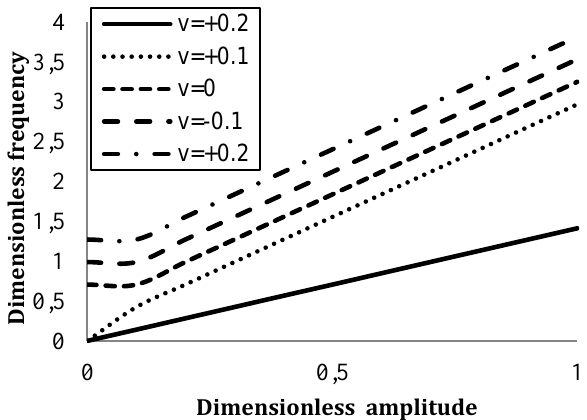
Figure 11: Dimensionless frequency vs. dimensionless amplitude for different nonlinear foundations. ( L / h = 20 , V = 0 , K w = K p = 20 , ∆T = 20 ∘ , α = 0.5 )